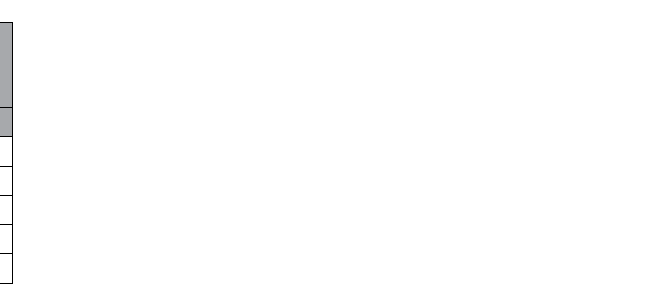
Table 5. Minimum inhibitory concentration (MIC) of ZA-S and penicillin against